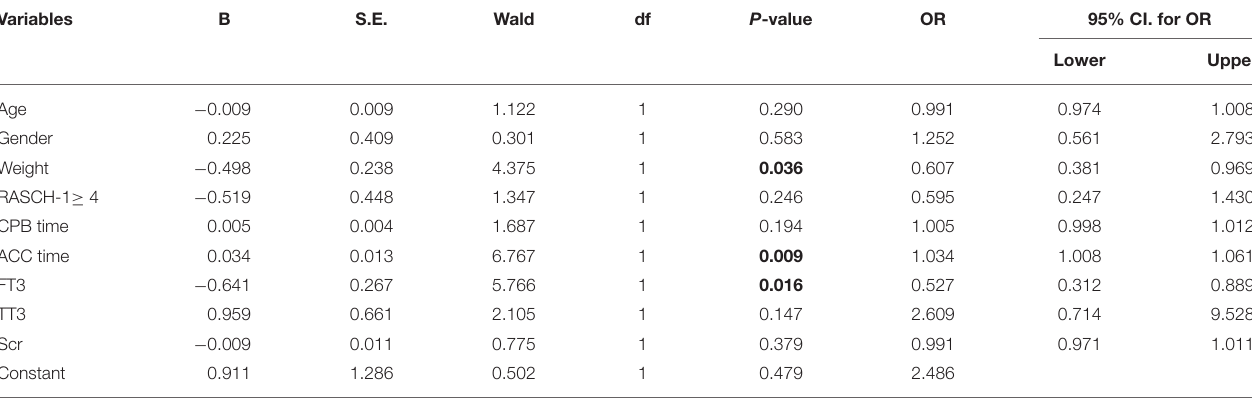
TABLE 3 | Multivariate logistic regression, odds ratio of variables for predicting LCOS in infants with CHD after CPB. Variables B S.E. Wald df P -value OR 95% CI. for OR